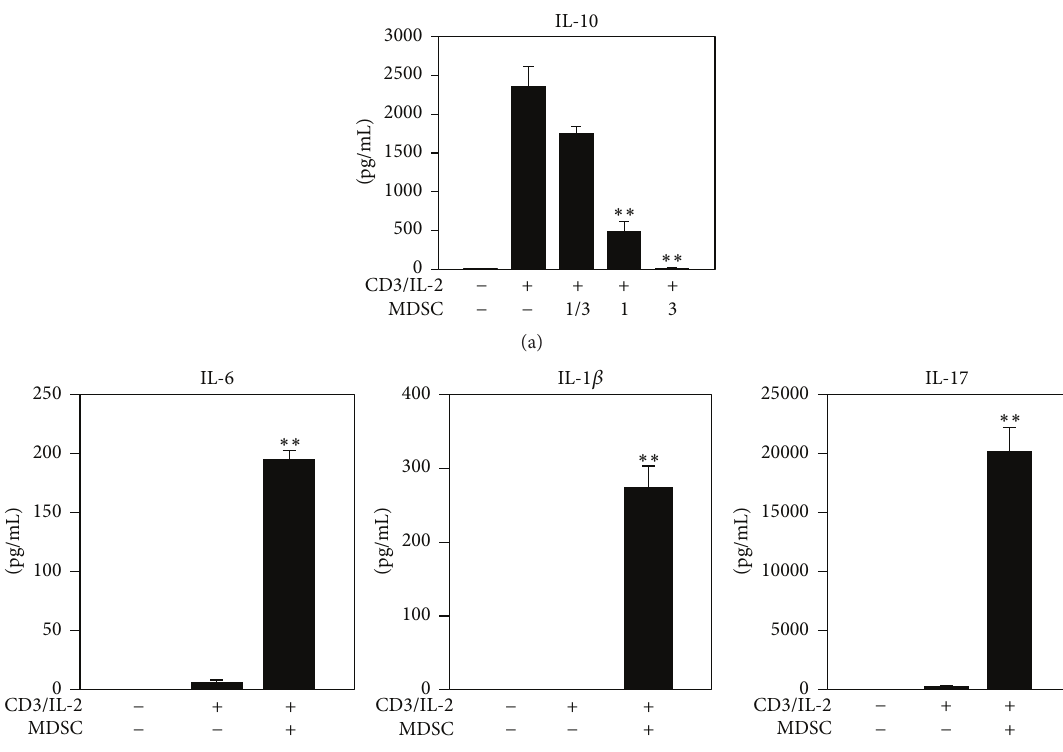
Figure 1: The effects of MDSCs on cytokine expression of T cells in coculture. Bio-Plex assays of indicated cytokines are shown. MDSCs and T cells were admixed at three ratios: 0.33 : 1, 1: 1, and 3 :1 (a) or 1:1 ratio (b) for five days. (a) Inhibited by MDSC coculture. (b) Cytokines of Th17 formation axis. 𝑛 = 4 . ∗∗ 𝑝 < 0.01